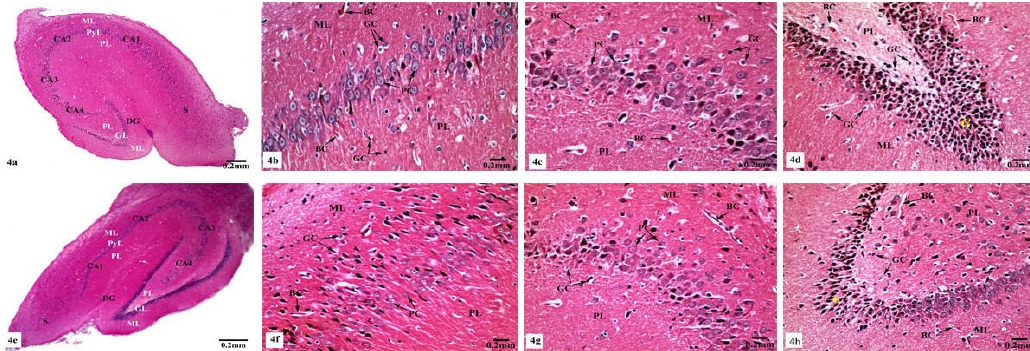
Figure 4. Photomicrographs of the hippocampal tissues of control ( a – d ) and SM-treated rats ( e – h ) stained with Hx&E showing ( a , e ) normal structure of cornu ammonis (CA), dentate gyrus (DG), and subiculum (S). CA is formed of the pyramidale layer (PyL) merged between the molecular layer (ML) and polymorphic layer (PL). CA1, CA2, CA3, and CA4 are subfields of the stratum pyramidale. The DG is seen surrounding CA4 by its upper and lower limbs and forming of molecular (ML), granular (GL), and polymorphic (PL) layers; ( b , f ) small pyramidal cells (PC) of the CA1 subfield appeared with large vesicular nuclei. Glial cells (GC) and blood capillaries (BC) are noticed in the molecular (ML) and polymorphic (PL) layers; ( c , g ) large pyramidal cells (PC) of CA3 region, most with vesicular nuclei. Additionally, glial cells (GC) and blood capillaries (BC) are seen; ( d , h ) compact closely packed granular cells (G) with dark stained nuclei are seen in the granular layer of the DG. Blood capillaries (BC) and glial cells (GC) are noticed in the molecular (ML) and polymorphic (PL) layers.